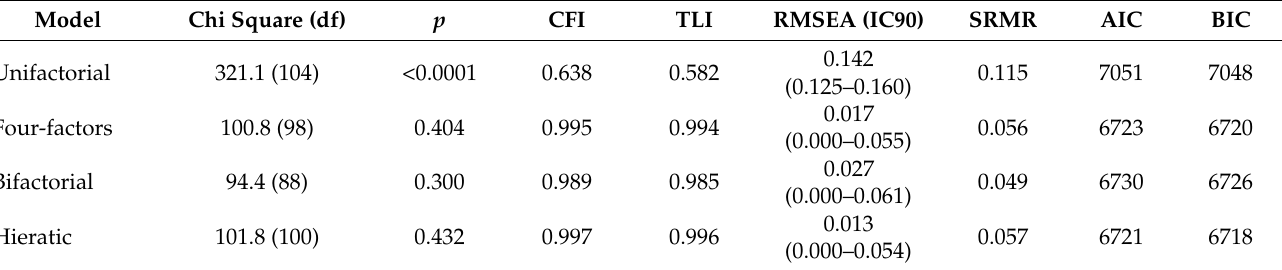
Table 3. Fit index values for the WEIP-S models.